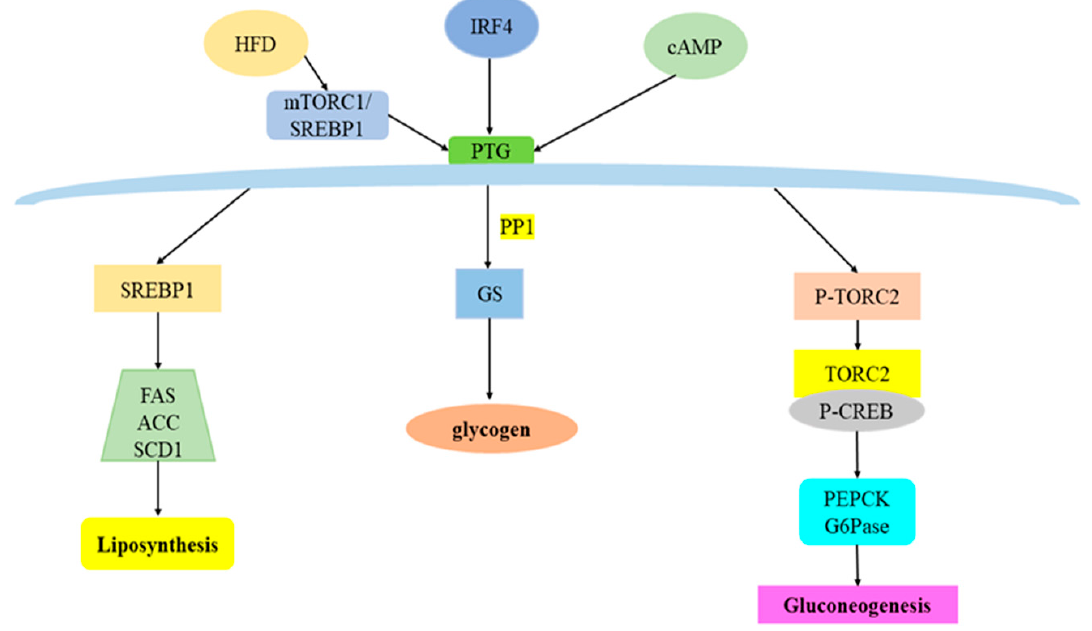
Figure 2. Possible PTG mediated crosstalk mechanism of glucose and lipid metabolism. The effect of PTG on fat metabolism is still controversial, but it can promote fat synthesis and promote the expression of related genes, such as SREBP1, FAS, SCD1, ACC. In addition to influencing glycogen synthesis, recent studies also found that PTG can promote the expression of PEPCK and G6Pase, key enzymes of gluconeogenesis, and then participate in